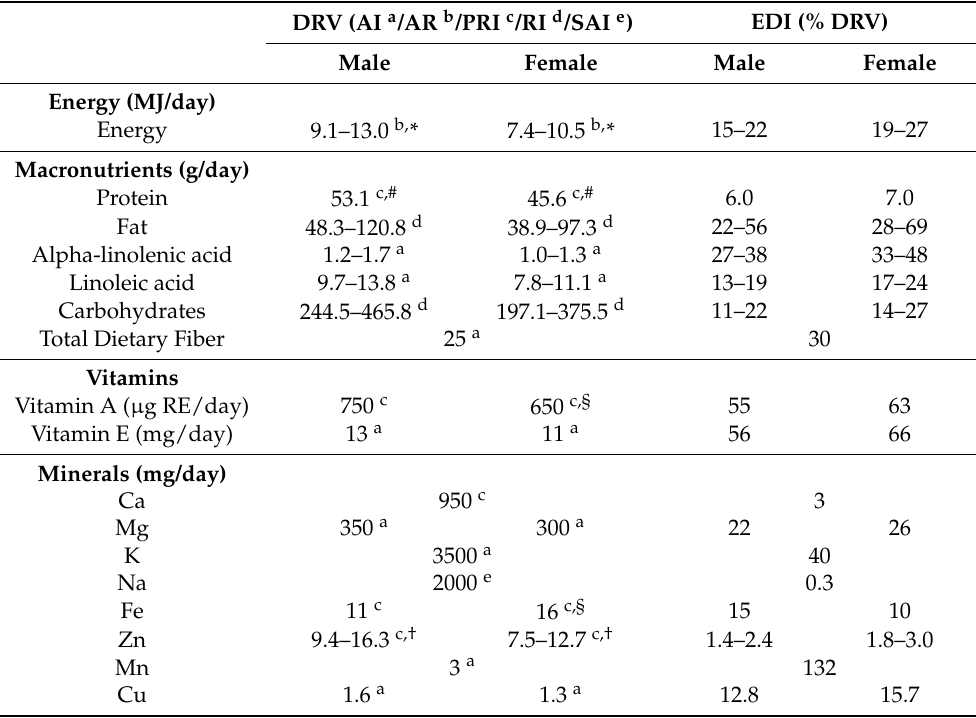
Table 6. Estimated daily intake (EDI), expressed as % of the dietary reference value (DRV) [22], of energy, macronutrients, vitamins and essential elements for adults considering an average per capita nfuma consumption of 100